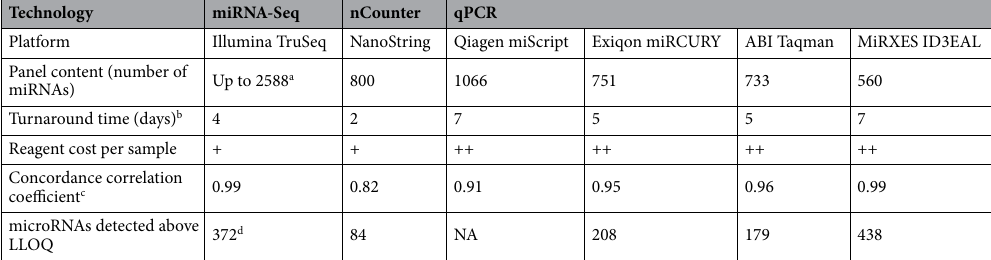
Table 2. Platform comparison. a Number of mature microRNAs in miRBase release 21. b To obtain expression data for 12 samples using one instrument. c Average of pairwise comparisons across a minimum of three independent runs. d Based on sequencing depth of 20 million reads.